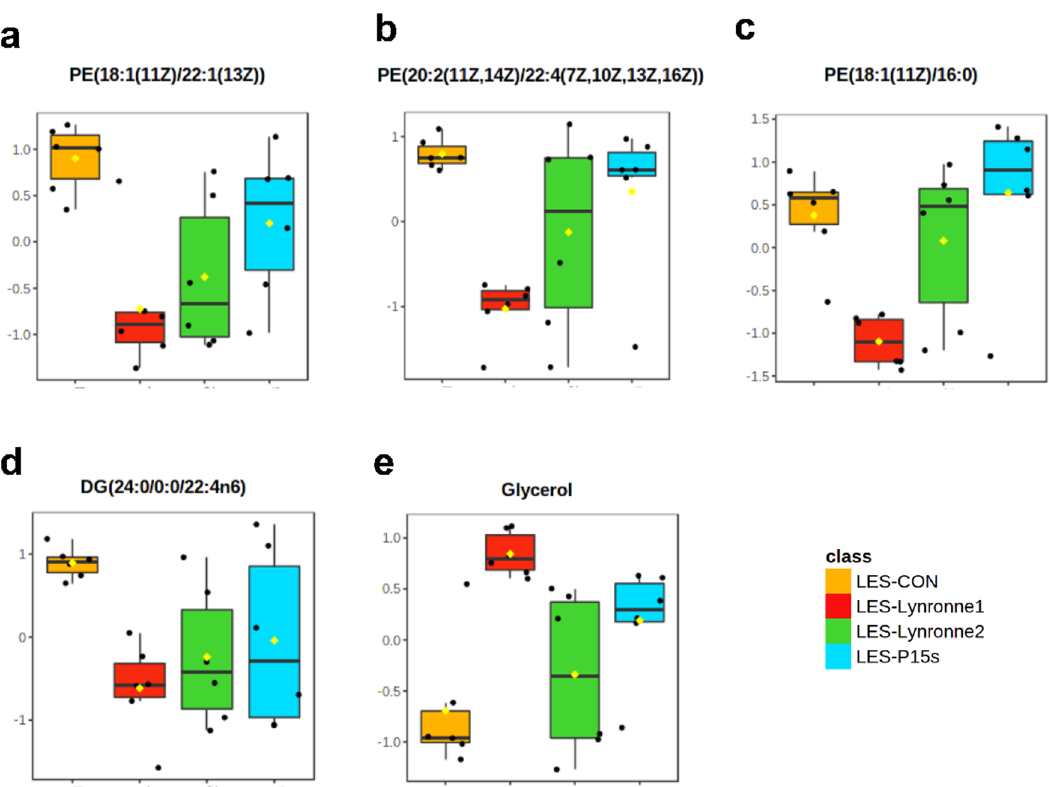
Fig. 7 Univariate analysis of metabolites. Boxplots of individual metabolites ( a – c ) phosphatidylethanolamines, ( d ) diglyceride and ( e ) glycerol, showing relative concentration differences between the untreated and peptide groups. Line across the box: median, square: mean, box: 25th and 75th percentiles, whiskers: 5th and 95th percentiles (univariate t test, P <